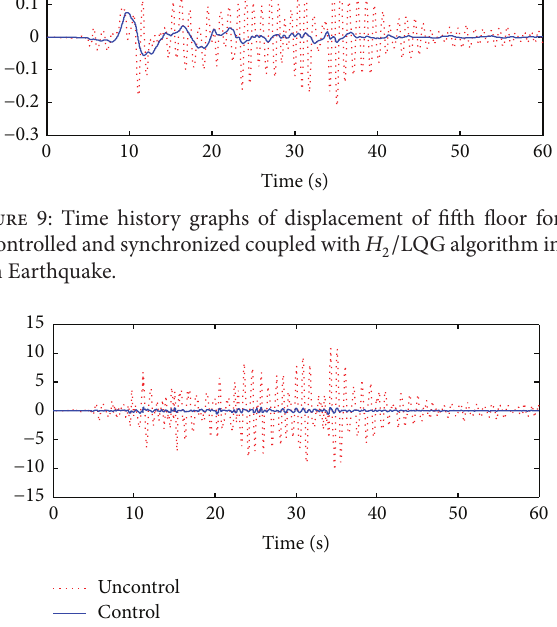
Figure 10: Time history graphs of acceleration of fifth floor for uncontrolled and synchronized control coupled with 𝐻 2 / LQG algorithm in Bam Earthquake.